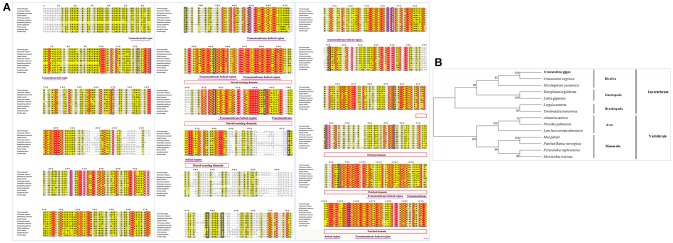
(A) Multiple sequence alignment of the CgSmo amino acid sequence among species. The conserved functional structure are marked in box. Identical residues are shown as white letters with red background, and similar residues are shown as black letters with yellow background. (B) Neighbor-joining phylogenetic tree based on the amino acid sequences of the CgSmo.